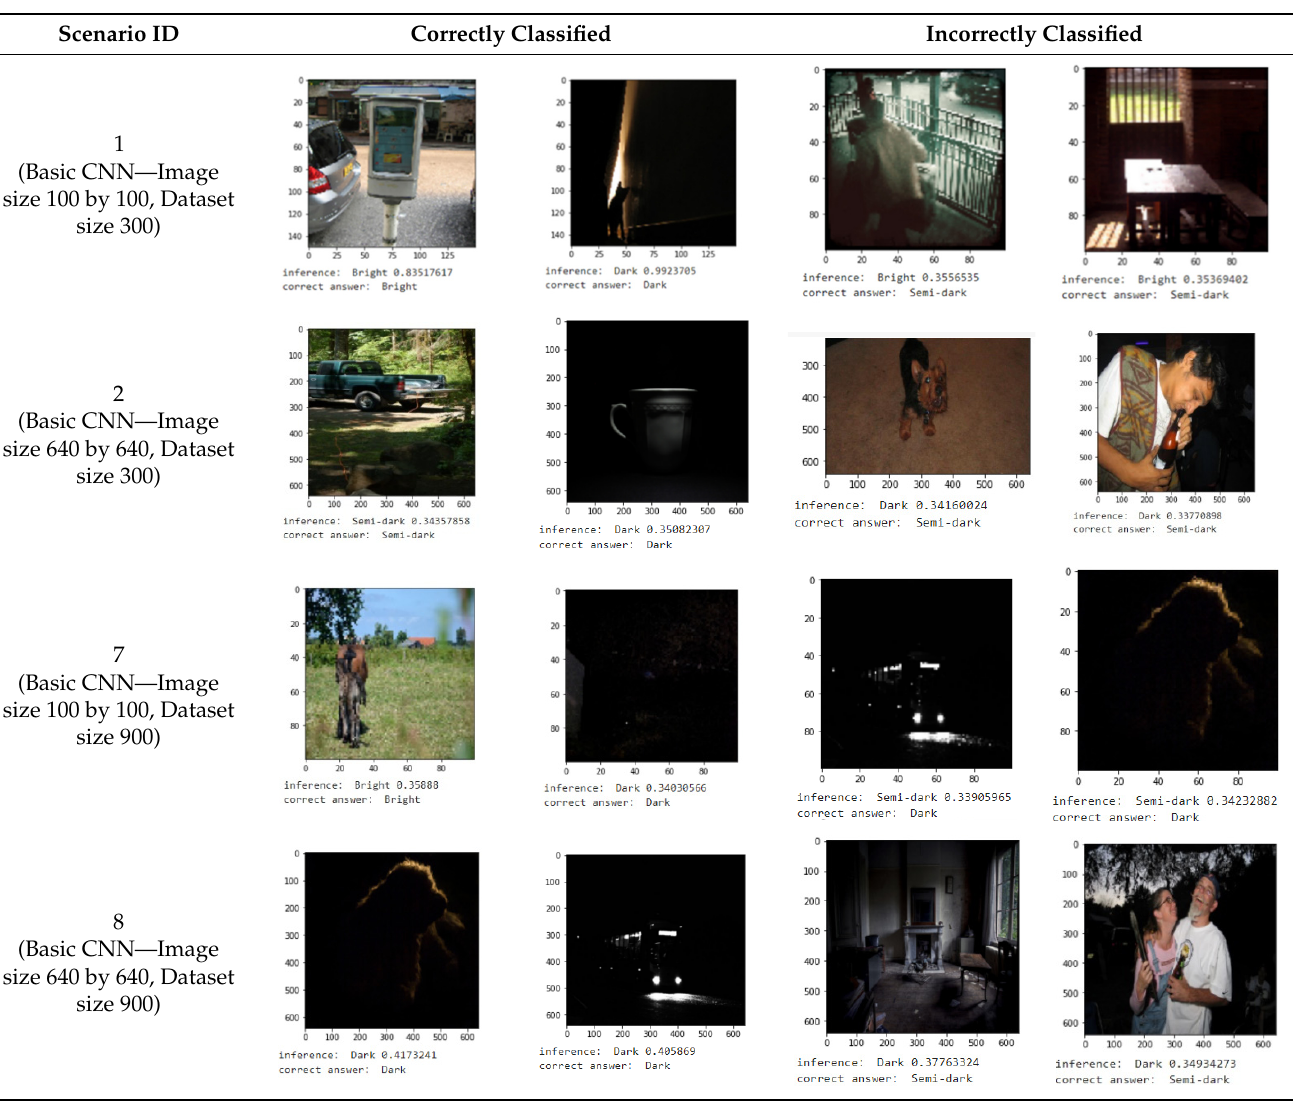
Table 4. Classification results of Basic CNN under Different Scenarios.